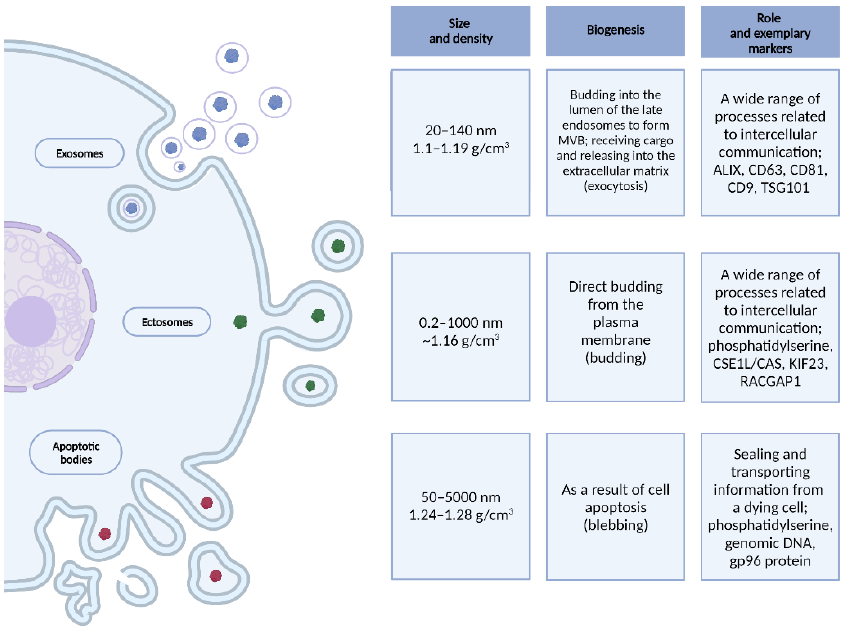
Figure 1. Size, density, biogenesis, role and exemplary markers of EVs–exosomes, ectosomes and apoptotic bodies. Created with BioRender.com.